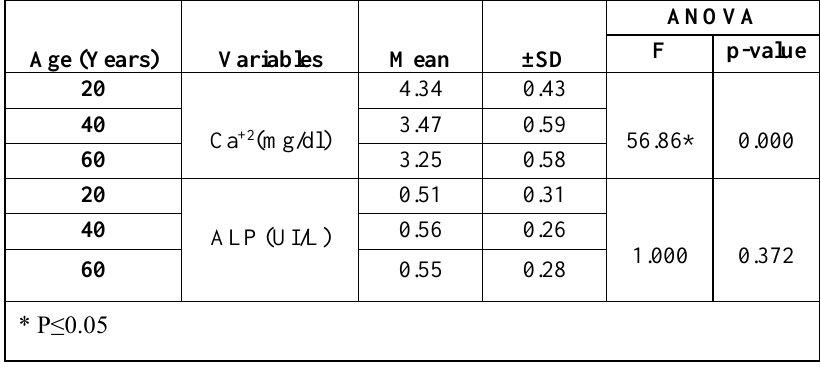
Table 6: Correlation coefficients between salivary calcium with caries components among Salivary variable